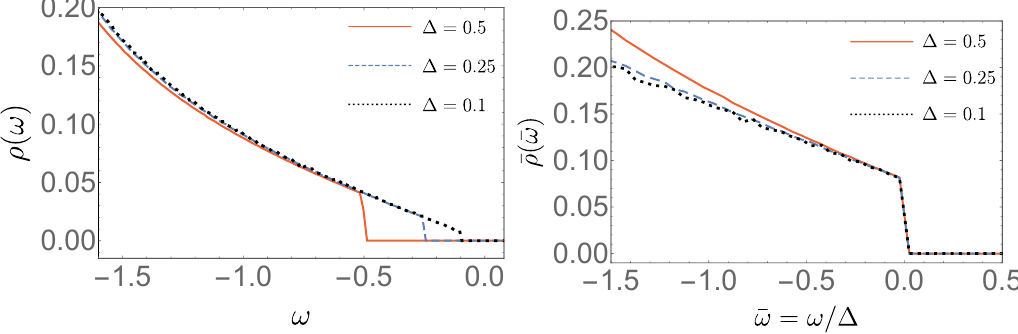
Figure 2: (color online) The numerical density of states ρ ( ω ) (left panel) and the rescaled densities ¯ ρ ( ¯ ω ) (right panel) for a ∆ -paired Minkowski system on a torus with a quasiparticle dispersion relation (67). We consider here a square lattice on a torus (periodic boundary conditions along both x and y ) of lengths 5000 ×